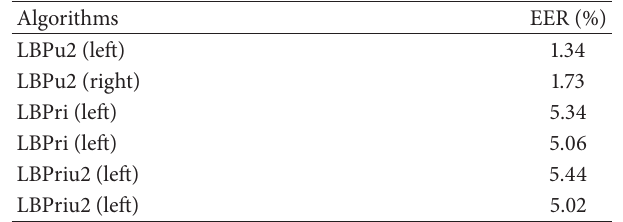
Table 7: Comparison of EER values using different databases.